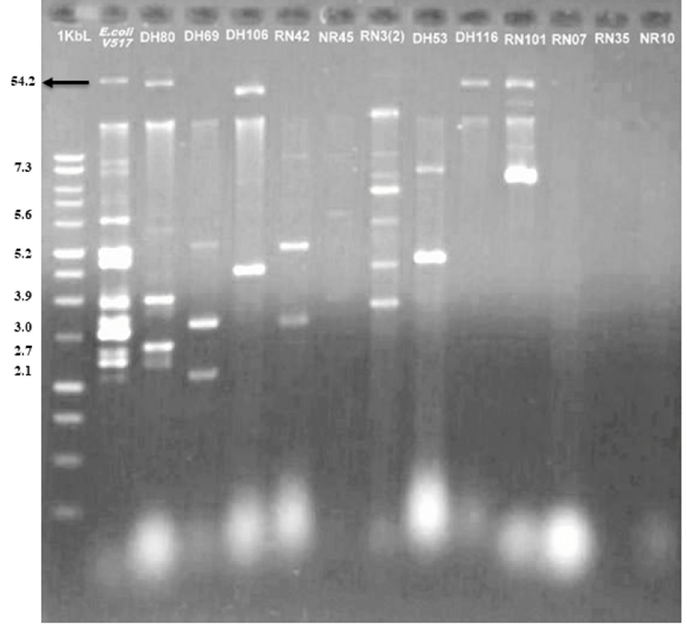
Figure 7. Plasmid profile of representative multidrug-resistant (MDR) APEC isolates. Agarose gel electrophoretogram (0.8% gel) of plasmid DNA of the MDR isolates: APEC strain DH80, DH69, DH106, RN42, NR45, RN 3(2), DH53, DH116, RN07, RN35, NR10 (from lane 3 to lane 14), E. coli V517 in lane 2 was used as the marker, and its plasmids of different sizes (kb) have been denoted in the figure. Lane 1 is molecular ladder. Plasmid bands at the same position was observed in APEC strain DH80, RN3(2) at the position between 3.9 kb; strain DH69, RN42 at the positions 3.0 kb, strain DH53, RN101 at the position of about 7.3 kb, and strain DH106, DH53, RN3(2) at the positions between 5.2 to 3.0 kb. Large plasmids at common positions were observed in strain DH80, DH106, DH116, RN101. Strain RN07, RN35, NR10 did not harbor any plasmid.